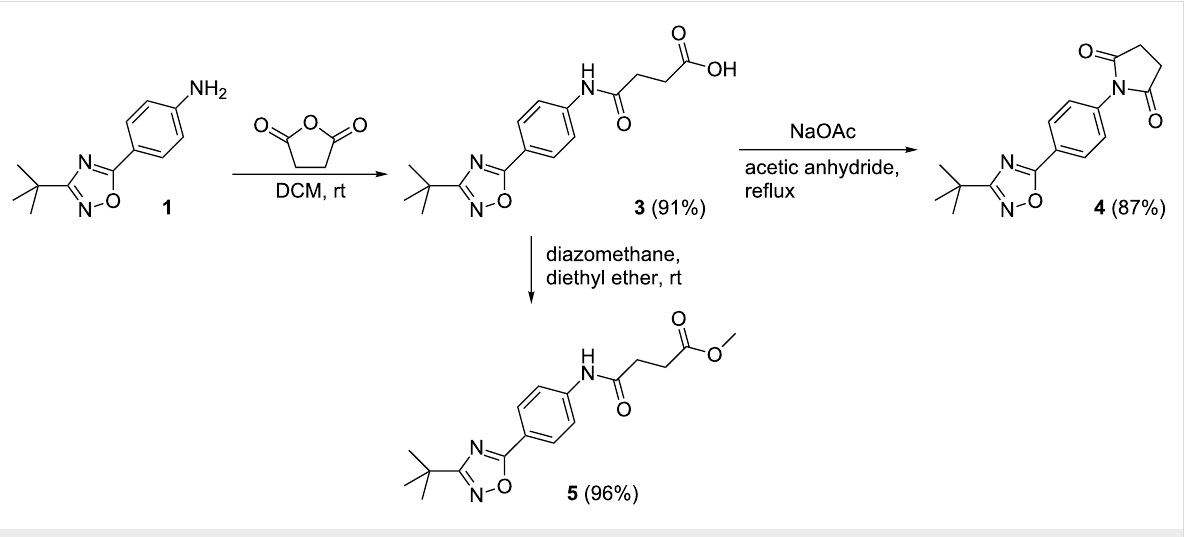
Scheme 4: Synthesis of 1-(4-(3- tert -butyl-1,2,4-oxadiazol-5-yl)phenyl)pyrrolidine-2,5-dione ( 4 ).